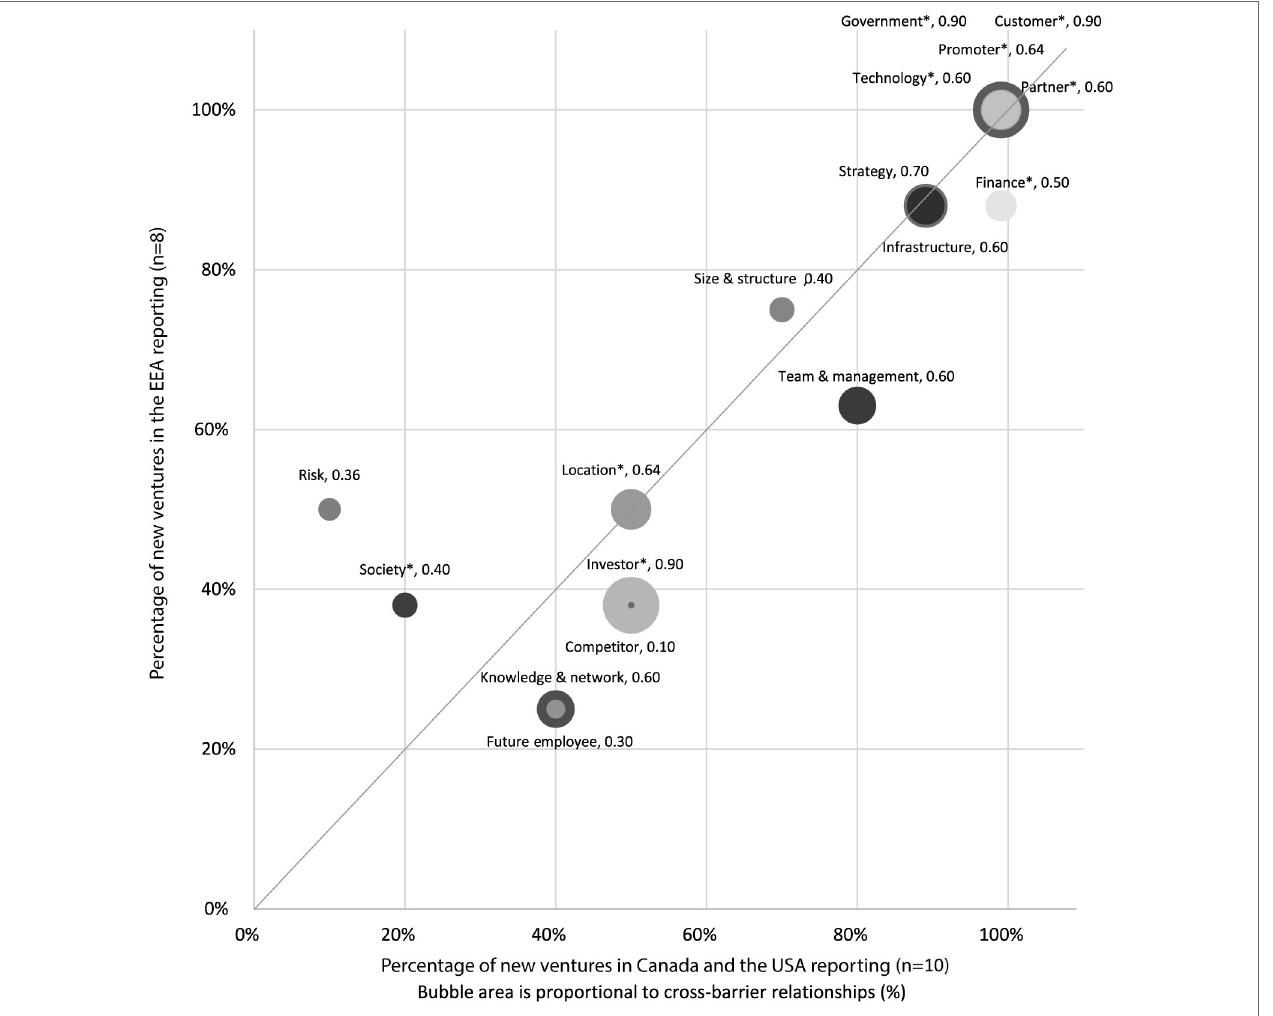
FigUre 5 | Reported barrier category matrix: Canada and USA vs. EEA. *Perceived main barrier reported in